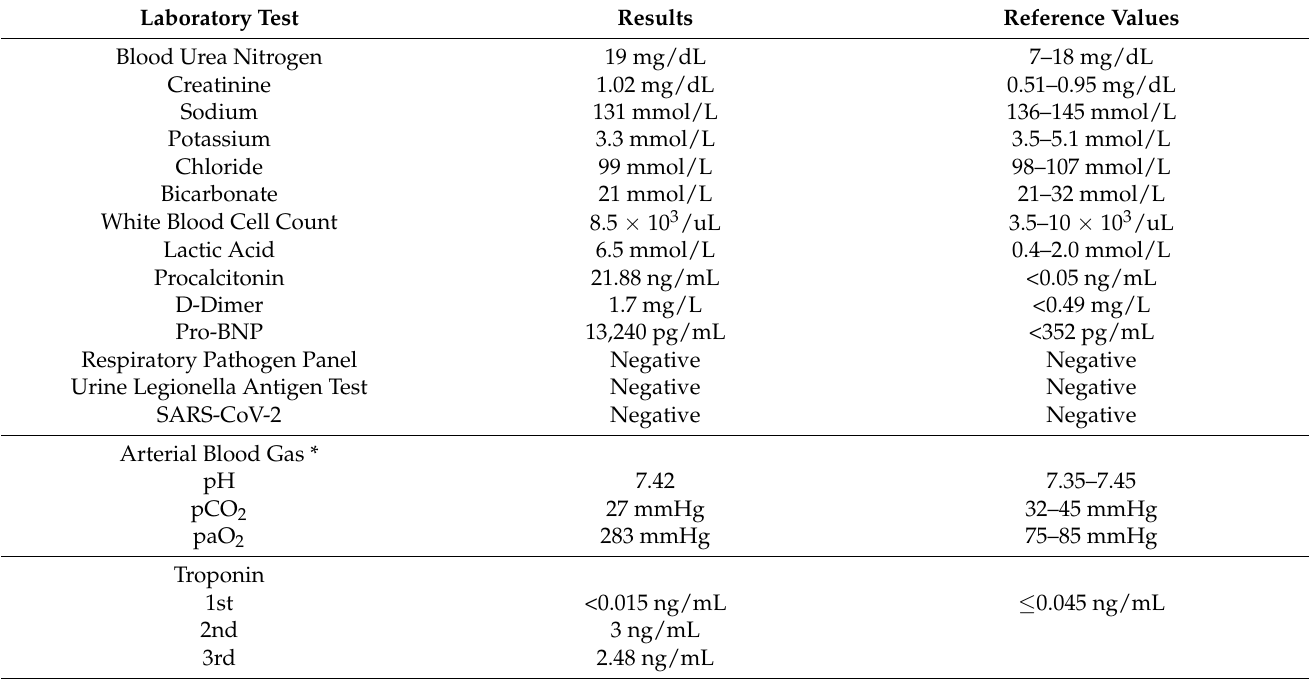
Table 1. Initial laboratory findings and